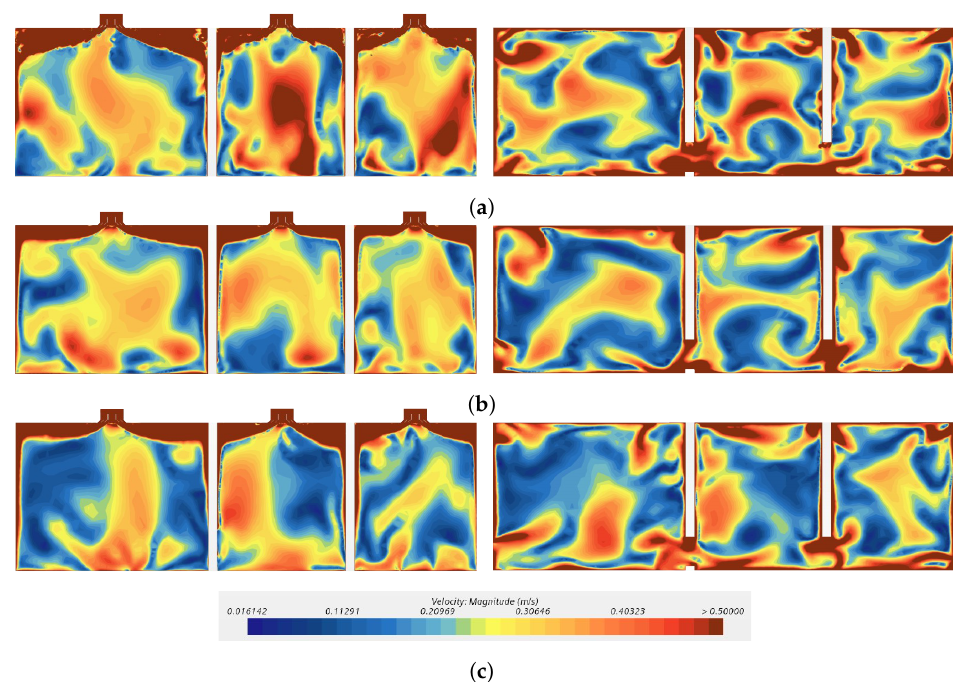
Figure 12. Numerical simulations: ( a ) Case 0; ( b ) Case 1; ( c ) Case 2 (legend included). Screenshots of velocity contours over the vertical medial planes (blocks of three along the left column—frontal view) and horizontal medial planes (blocks of three along the right column—superior view) for each case and room. The velocity range is scaled, and the time instant is